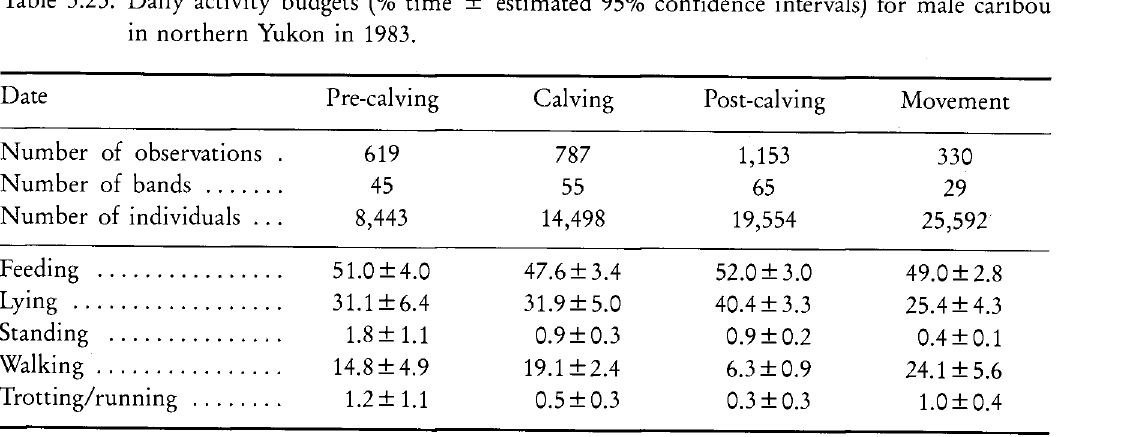
Table 3.26. Length (minutes) of active and resting periods (x ± SE) for male caribou in northern